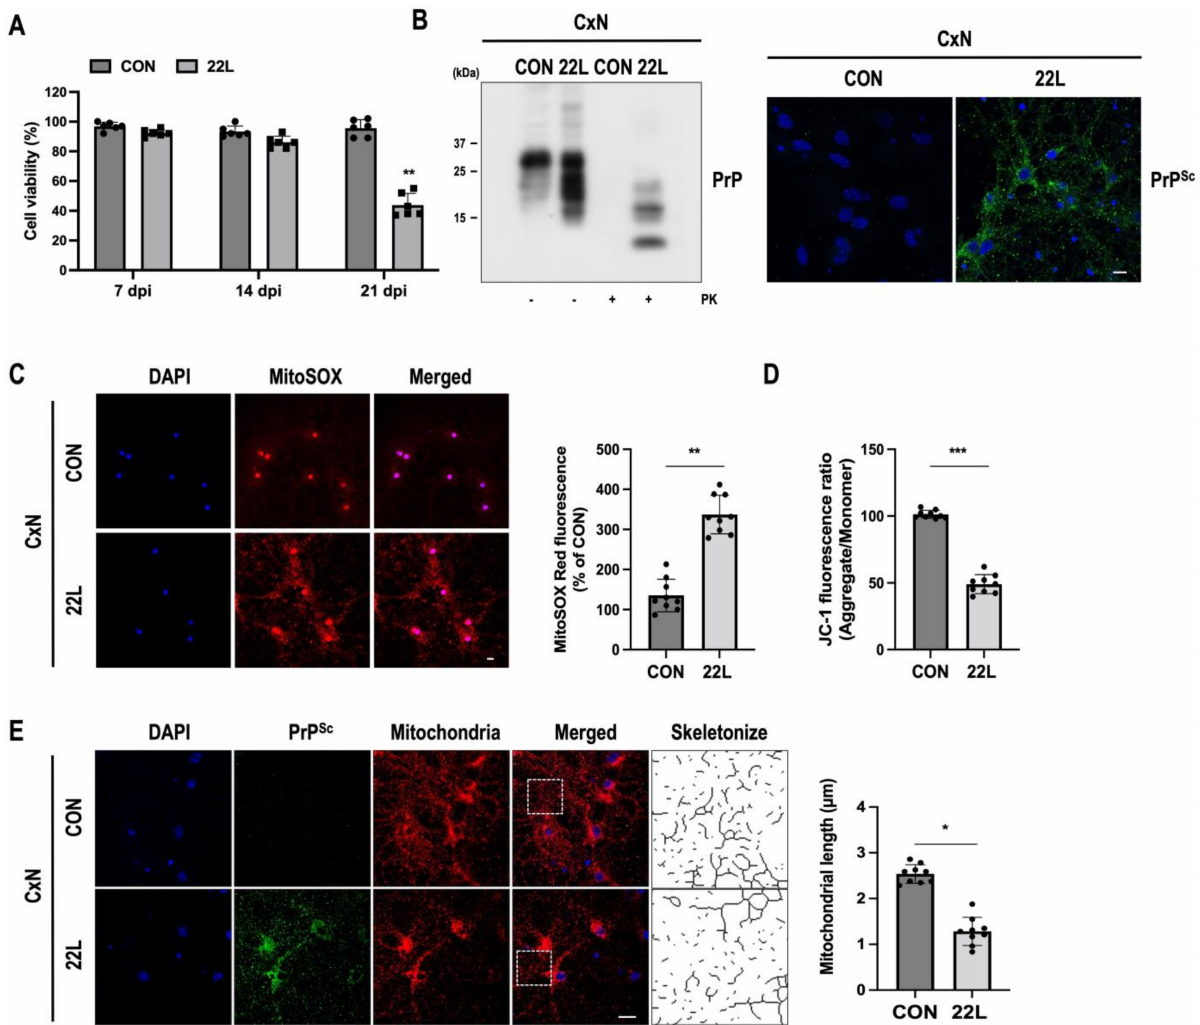
Figure 1. Scrapie infection induces mitochondrial ROS (mtROS) production and the loss of the mitochondrial membrane potential ( ∆Ψ m) followed by mitochondrial fragmentation. ( A ) The relative cell viability of primary cortical neuronal (CxN) cells infected with either normal brain homogenate (CON) or 22L scrapie-infected brain homogenate (22L) for 7, 14, and 21 days post infection (dpi). Representative data is relative to controls of each time point, respectively, and analyzed using CCK8 reagent ( n = 6, ** p < 0.01; two-sided Student’s t -test). ( B ) Deposition of prion protein (PrP) in control (CON) and 22L scrapie-infected (22L) CxN cells at 21 dpi. PrP was detected using an anti-PrP (3F10) antibody by Western blot analysis in the presence or absence of proteinase K (PK) (20 µ g/mL). Using confocal microscopy, PrP Sc was detected with an anti-PrP (C-20) antibody after treatment with 98% formic acid (right panel). Scale bar, 20 µ m. ( C ) Detection of mitochondrial ROS (mtROS) by MitoSOX staining (red) using confocal microscopy in control (CON) and 22L scrapie-infected (22L) CxN cells at 21 dpi. The intensities of the mtROS fluorescence were measured and quantified for each group ( n = 9, ** p < 0.01; two-sided Student’s t -test). ( D ) The ∆Ψ m was evaluated with JC-1 staining using a fluorescence reader ( n = 9, *** p < 0.001; two-sided Student’s t -test). ( E ) Quantification of mitochondrial length with staining for the mitochondrial-specific marker TOM20 (red) and PrP Sc (green) under confocal microscopy, and the morphological skeleton was analyzed with algorithm (Momito; n = 9, * p < 0.01; two-sided Student’s t -test). PrP Sc (green) was detected with an anti- PrP (C-20) antibody after treatment with 98% formic acid. Nuclei were stained with DAPI (blue); n = number of independent experiments. Enlarged insets (dashed white line boxes) showed the sections at a higher magnification, scale bar, 20 µ m. Bullets in bar graph represent datasets from independent